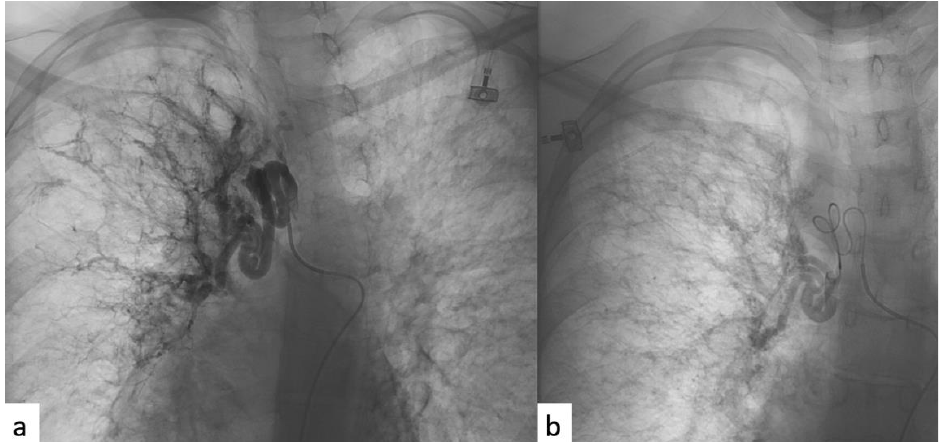
Figure 2. ( a ) Angiographic imaging pre-procedure, performed through selective catheterism of right bronchial artery, showing ectatic and tourtuous bronchial arteries coming from upper and medium lung lobes. ( b ) Angiographic imaging post-procedure, after super-selective BAE with microspheres, showing reduction in blood intake at the level of the treatment.